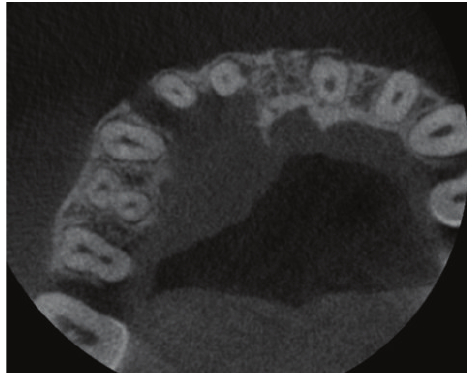
Figure 6: Pre-operative CBCT image in axial plane showing disrup- tion of buccal and palatal